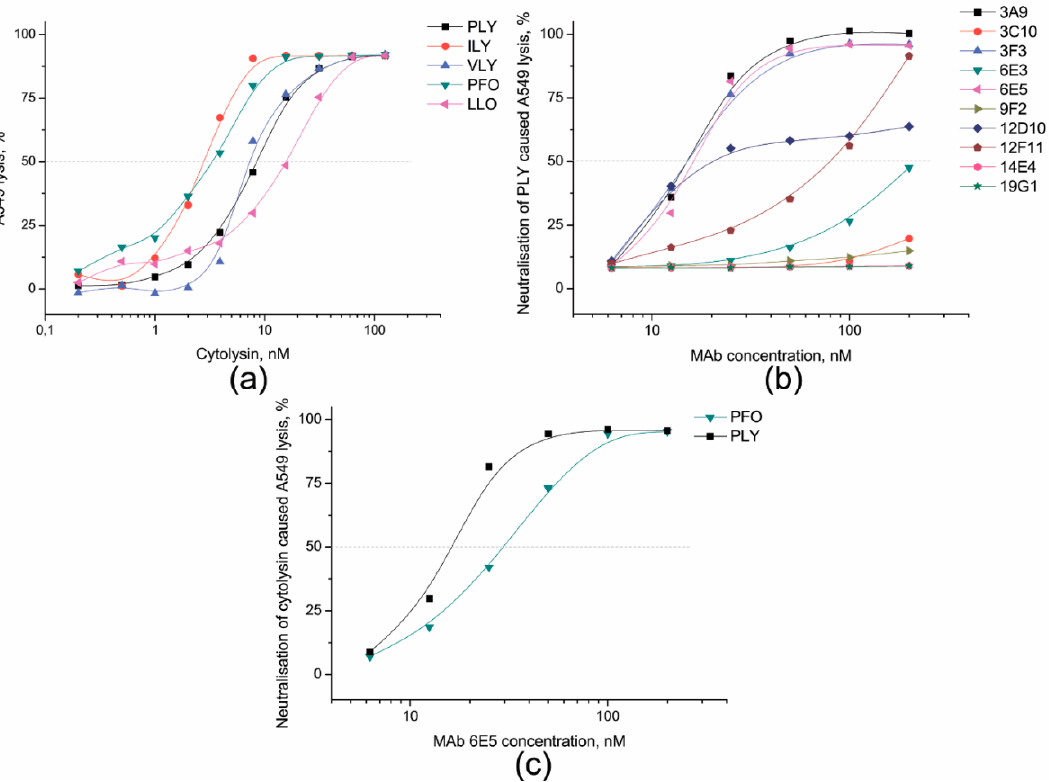
Figure 5. The dose-dependent curves representing cytolysis of human lung epithelial A549 cells induced by PLY, ILY, VLY, PFO, and LLO ( a ), neutralisation of 1HU PLY induced cytolysis by the MAbs 3A9, 3C10, 3F3, 6E3, 6E5, 9F2, 12D10, 12D11, 14E4, 19G1 in range of centration 6.3–200 nM ( b ) and neutralisation of 1HU of PFO-induced lysis by the MAb 6E5 within a concentration range of 6.3–200 nM ( c ).